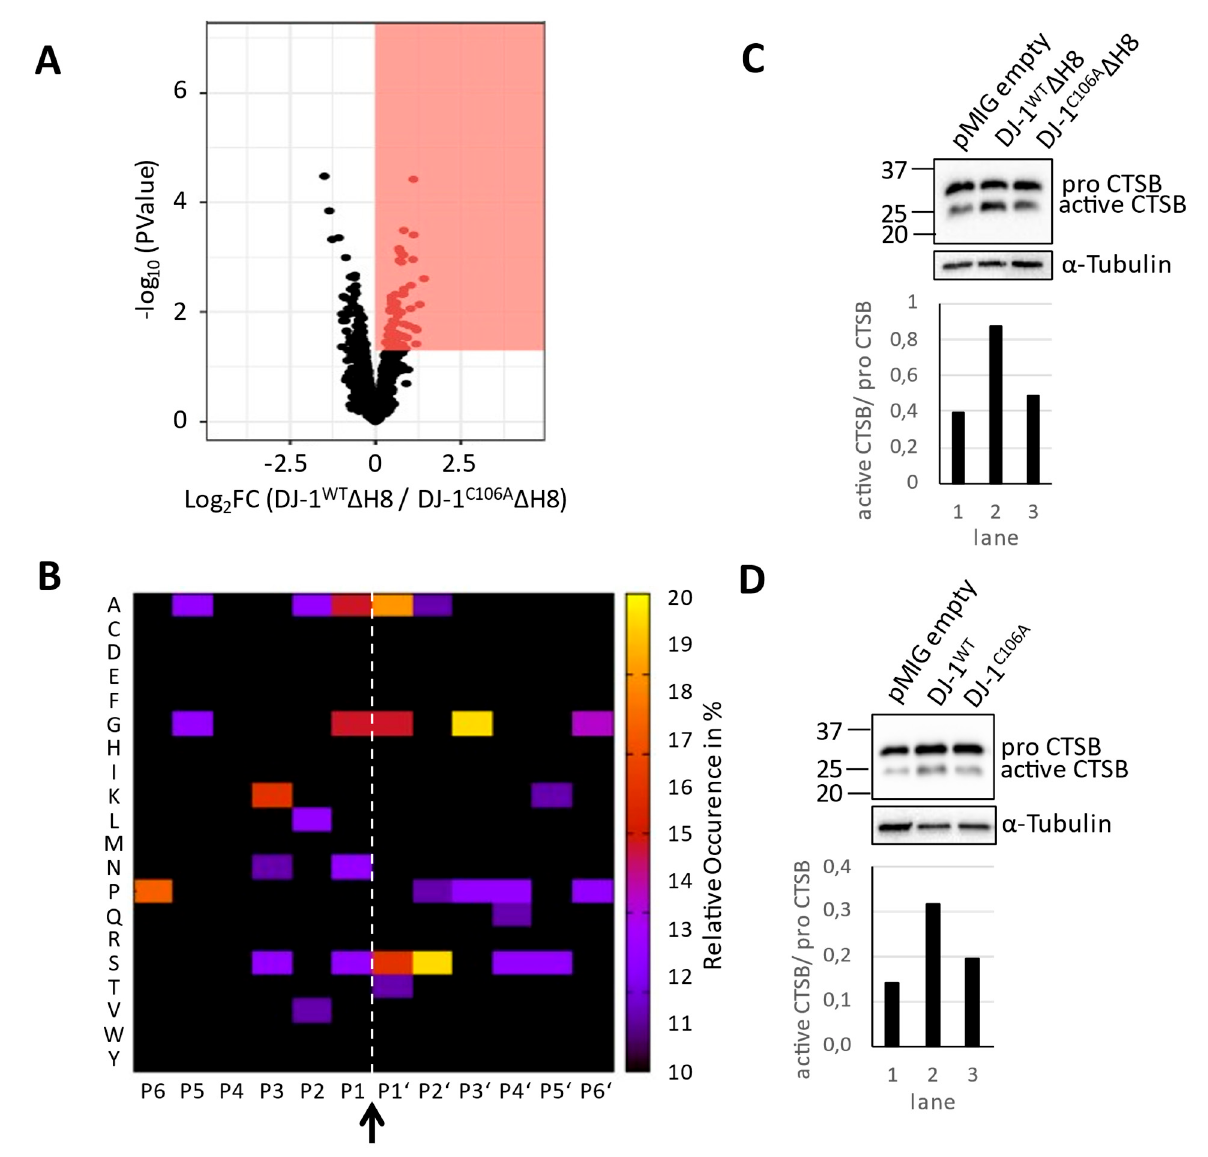
Figure 2. Degradome analysis: ( A ) Volcano plot representation of the TAILS experiment of DJ-1 WT Δ H8 and DJ-1 C106A Δ H8 overexpressing cells following LIMMA analysis, red box: proteins with higher abundance in DJ-1 WT Δ H8 cells and p limma < 0.05 ( B ) Heatmap of the occurrence of amino acids in each position, P6-P6 ′ , of peptides with higher abundance in DJ-1 WT Δ H8 cells following LIMMA analysis relative to the natural abundance levels of amino acids in humans (arrow and dashed line highlight the hydrolysis site, P1 to P6 were derived bioinformatically) ( C ) and ( D ) Cathepsin B (CTSB) Immunoblots with α -Tubulin as loading control (upper panels) and quantification of the amount of active CTSB (lower panels).